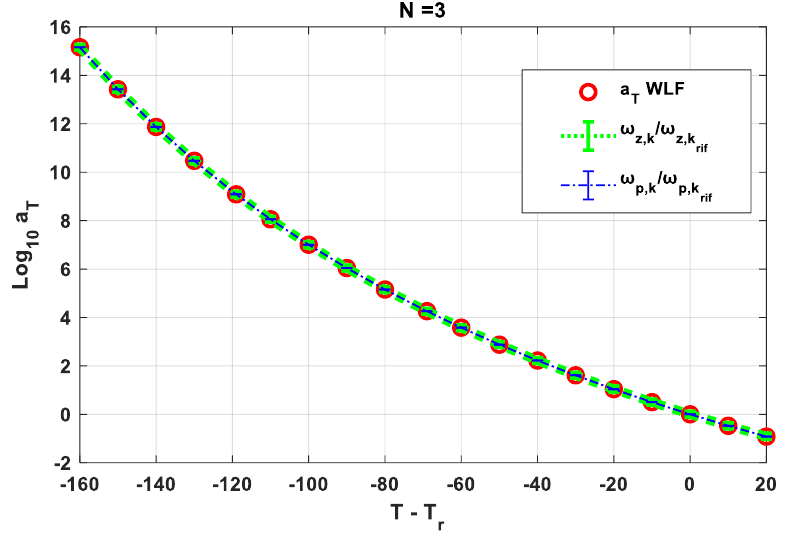
Figure 5. Relation between poles, zeros, and WLF law. Therefore, the validity of the WLF principle through the material transformation to the poles–zeros formulation has been highlighted. Here, it is worth noting that all that has been demonstrated for the FDGM pole–zeros formulation is still valid for the generalized formulation (in Maxwell and Kelvin–Voight